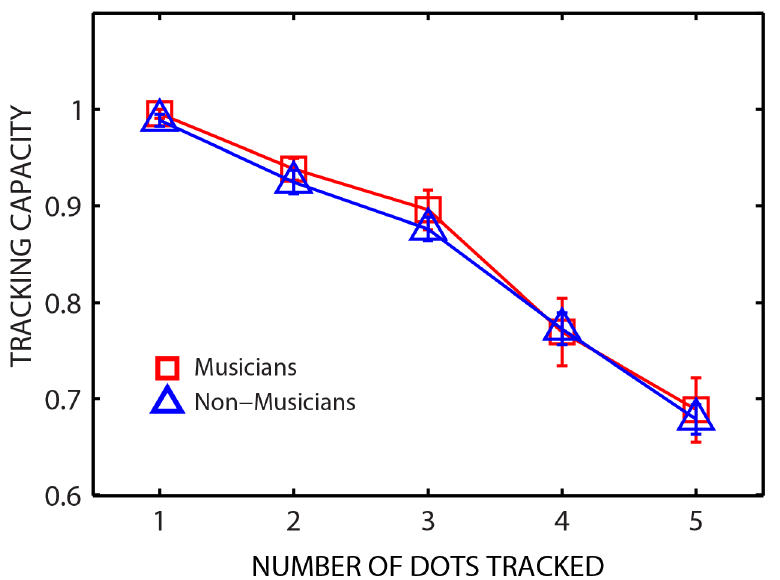
Fig 3. Performance of musicians and non-musicians in the multiple object tracking (MOT) task. Group mean tracking capacity data for musicians (red squares) and non-musicians (blue triangles). Error bars show ± 1 standard error of the